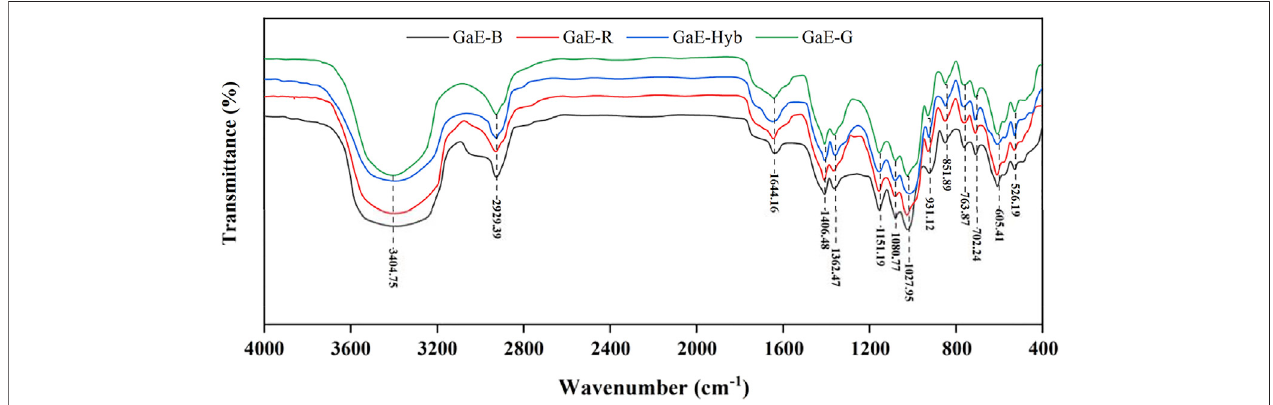
FIGURE 3 | FT-IR spectra of the Gastrodia elata polysaccharides with four different varieties.